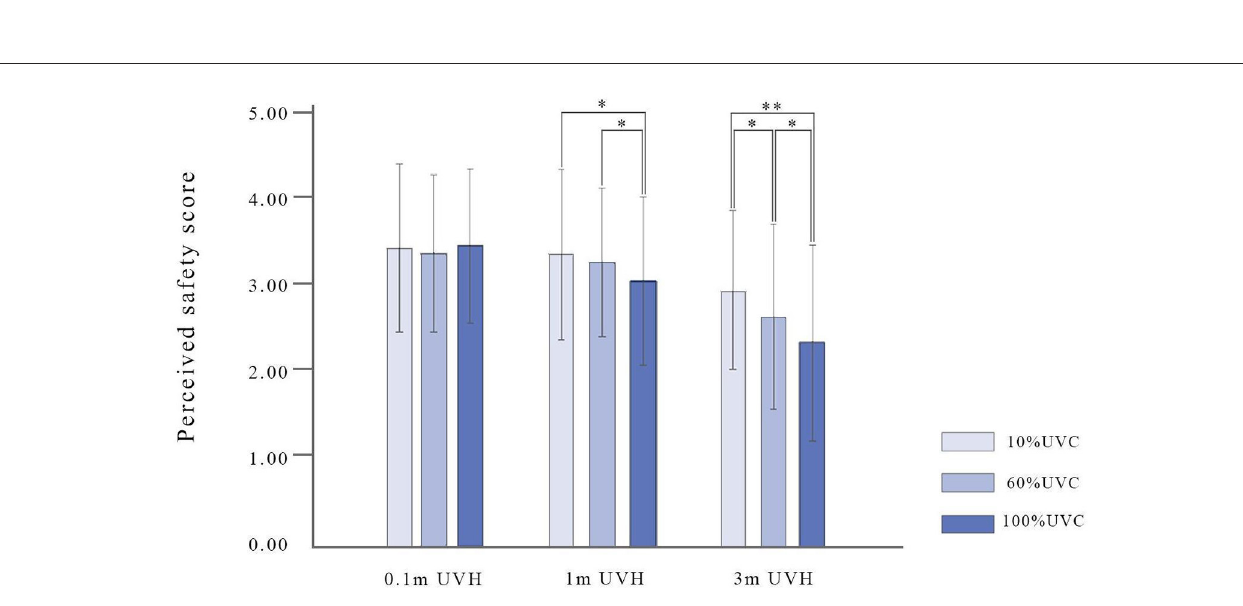
( r = − 0.09, p < 0.01). UVC level is strongly negatively related to perceived safety ( r = − 0.10, p < 0.01). UVH level is strongly positively related to average pupil diameter ( r = 0.07, p <